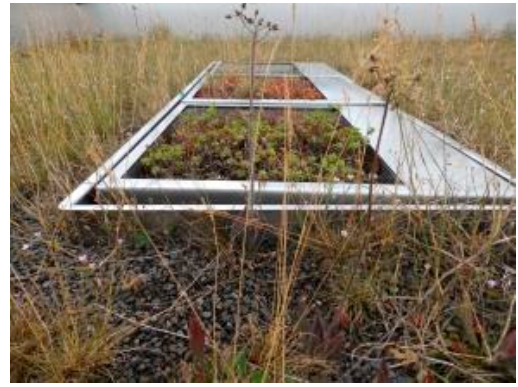
Figure 2. Lysimeter built in an EGR at the University of Applied Sciences in Neubrandenburg, Germany.